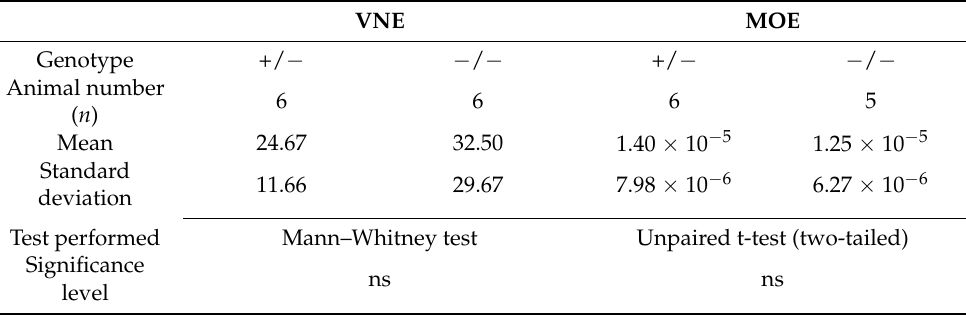
Table 1. Activated caspase-3-positive cells in the vomeronasal epithelium (VNE) and in the main olfactory epithelium (MOE) in 6-month-old